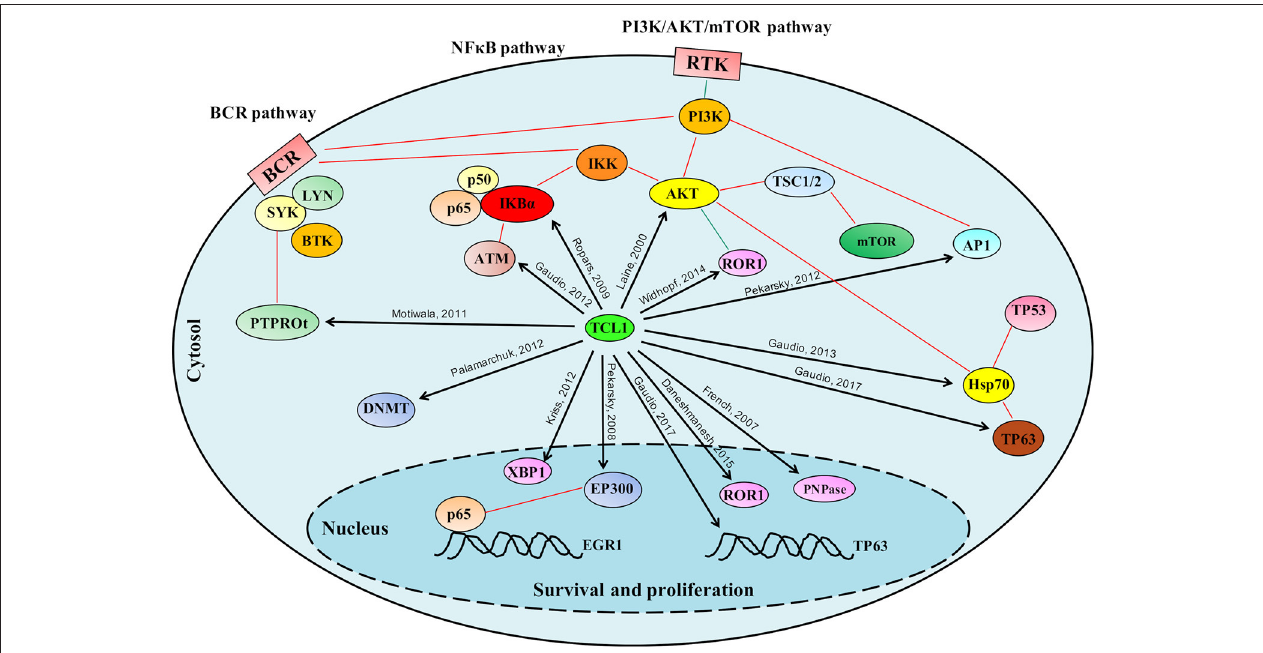
FIGURE 2 | Schematic representation of the role played by TCL1 in multiple signaling pathways. TCL1 regulates many proteins responsible for cellular proliferation, survival and epigenetic regulation through multiple signaling pathways. TCL1 promotes the activation of the PI3K/AKT/mTOR pathway directly through its interactions with AKT, AP1 elements (c-JUN, c-FOS), and ROR1, and indirectly by inhibiting the tumor suppressor PTPROt and sustaining the BCR pathway. TCL1 enhances the activation of the NF- κ B pathway by direct actions on I κ B alpha and ATM. Other signaling pathways mediated by physical interactions of TCL1 with p63 and HSP70 or with EP300 supports the PI3K/AKT/mTOR and the NF- κ B pathways, respectively. Black arrows indicate the protein-protein interactions described in the text; Red lines represent published interactions among proteins and